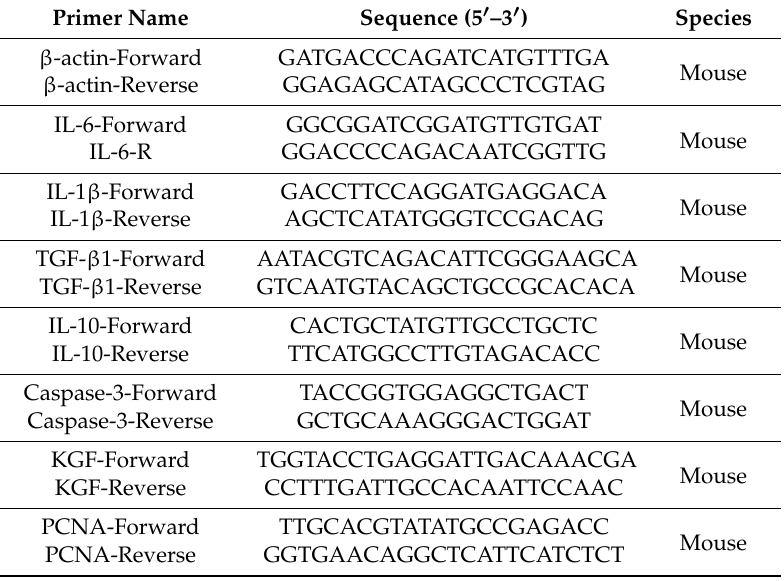
Table 1. Primers Used for Real-Time